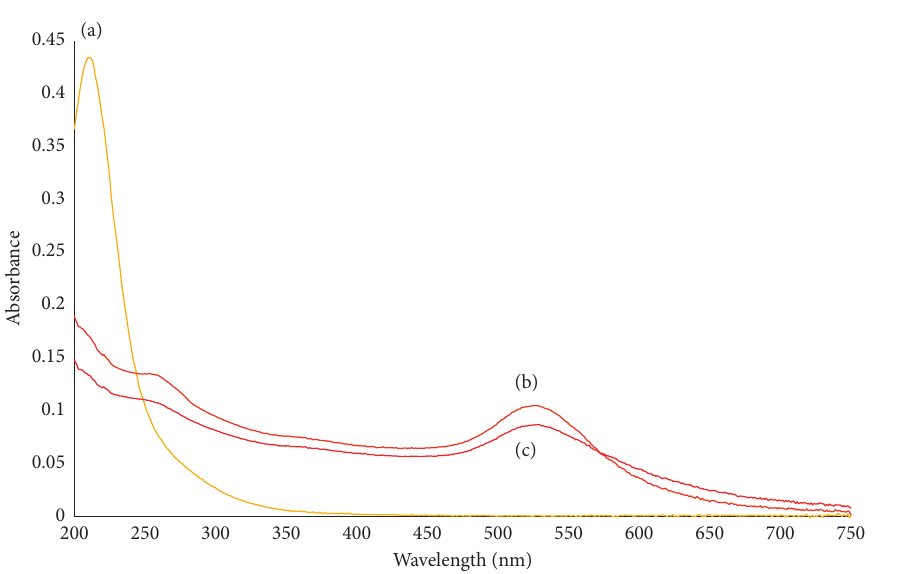
Figure 3: UV-Vis absorbance spectra of (a) HAuCl 4 solution and suspensions of (b) Cit-HAuNPs and (c) Cit-MAuNPs.